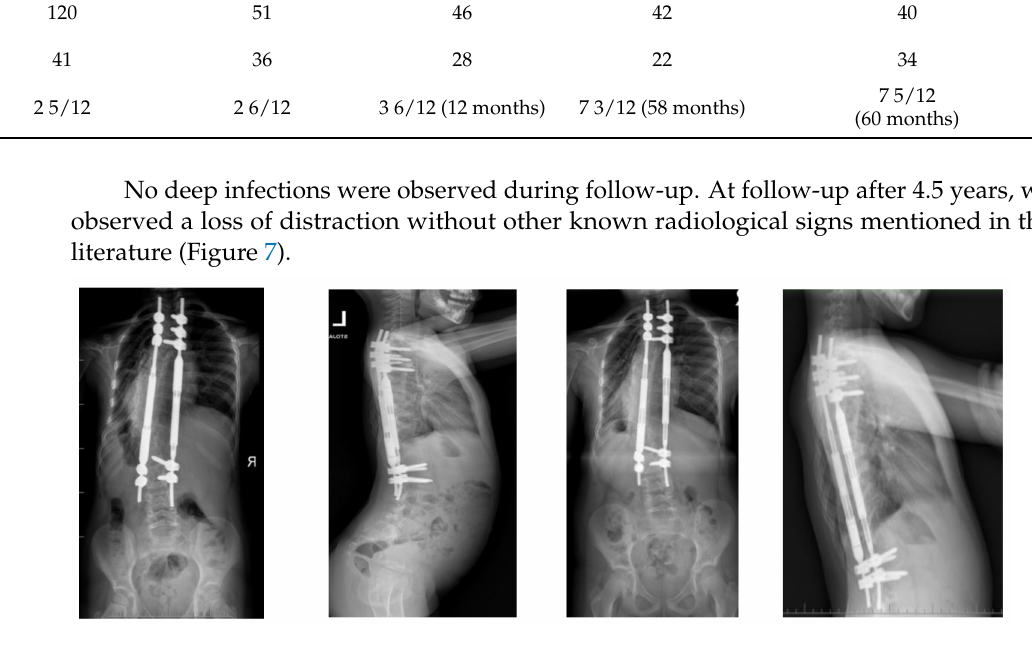
Figure 7. X-rays at follow-up after 1 year ( left AP and LAT) and at follow-up after 4.5 years ( right AP and LAT) before revision surgery for MCGR replacement.